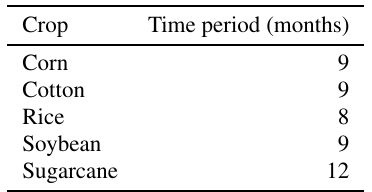
Table 2. Time range of the various crops studied in this paper based on crop